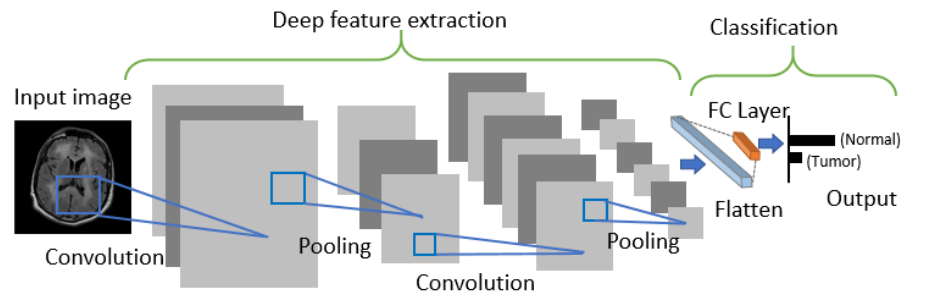
Figure 3. Architecture of Convolutional Neural